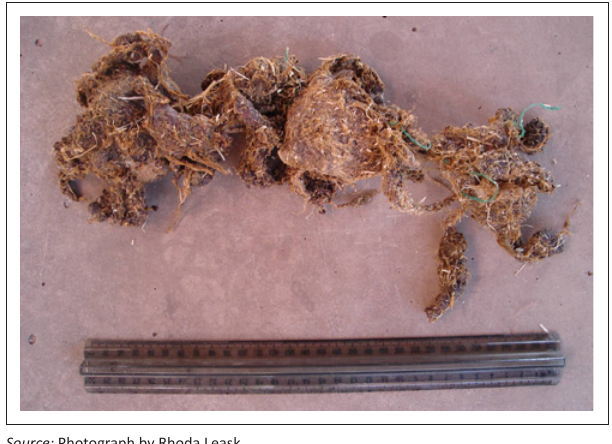
FIGURE 2: The amorphous mass removed from the affected ram, approximately 30 cm long and 10 cm wide (ruler marked in centimetres for size comparison) .